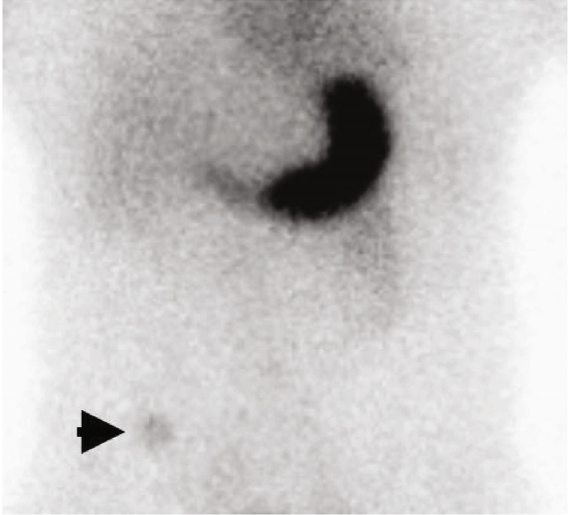
Figure 4: Technetium-99m pertechnetate showing uptake (arrow) of ectopic gastric mucosa in the right lower quadrant of the abdomen, con fi rming the diagnosis of Meckel ’ s diverticulum.